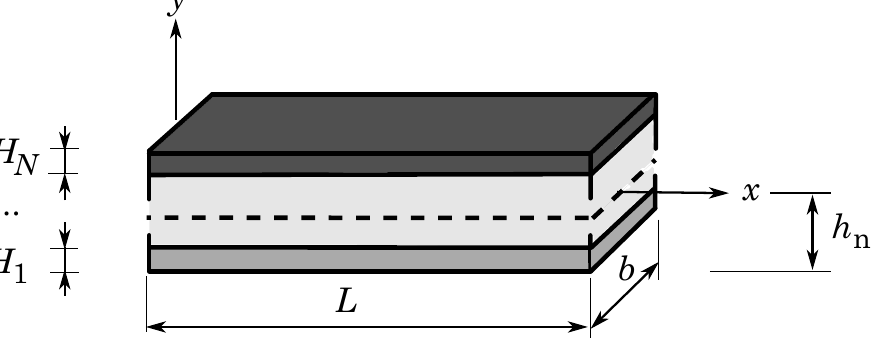
Figure 1. N-layered beam, H i , h n , L , and b stand for the thickness of the i th layer, the position of the neutral fibre, the length of the beam and its width,